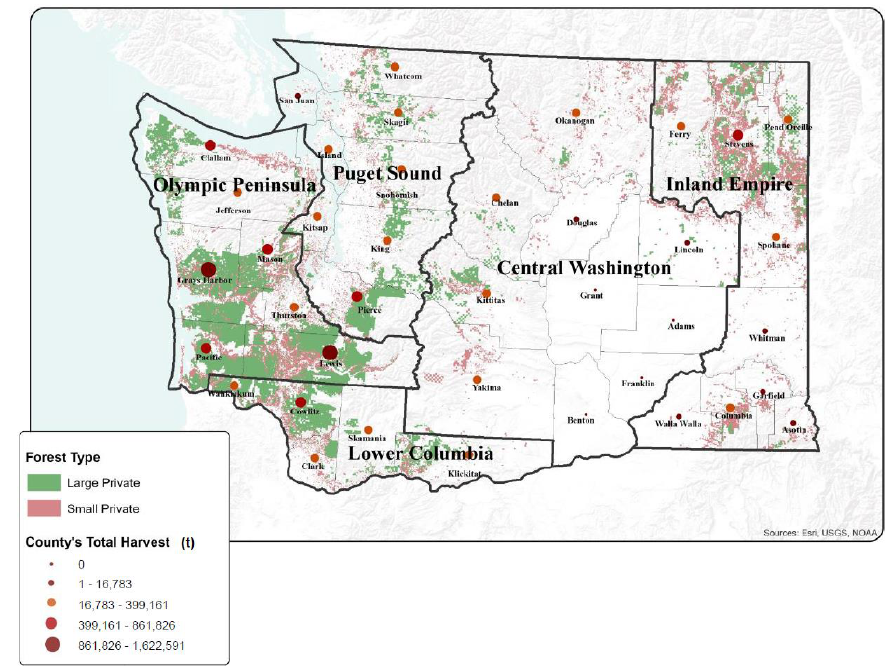
Figure 1. Total harvest in Washington state’s private forest in 2015.